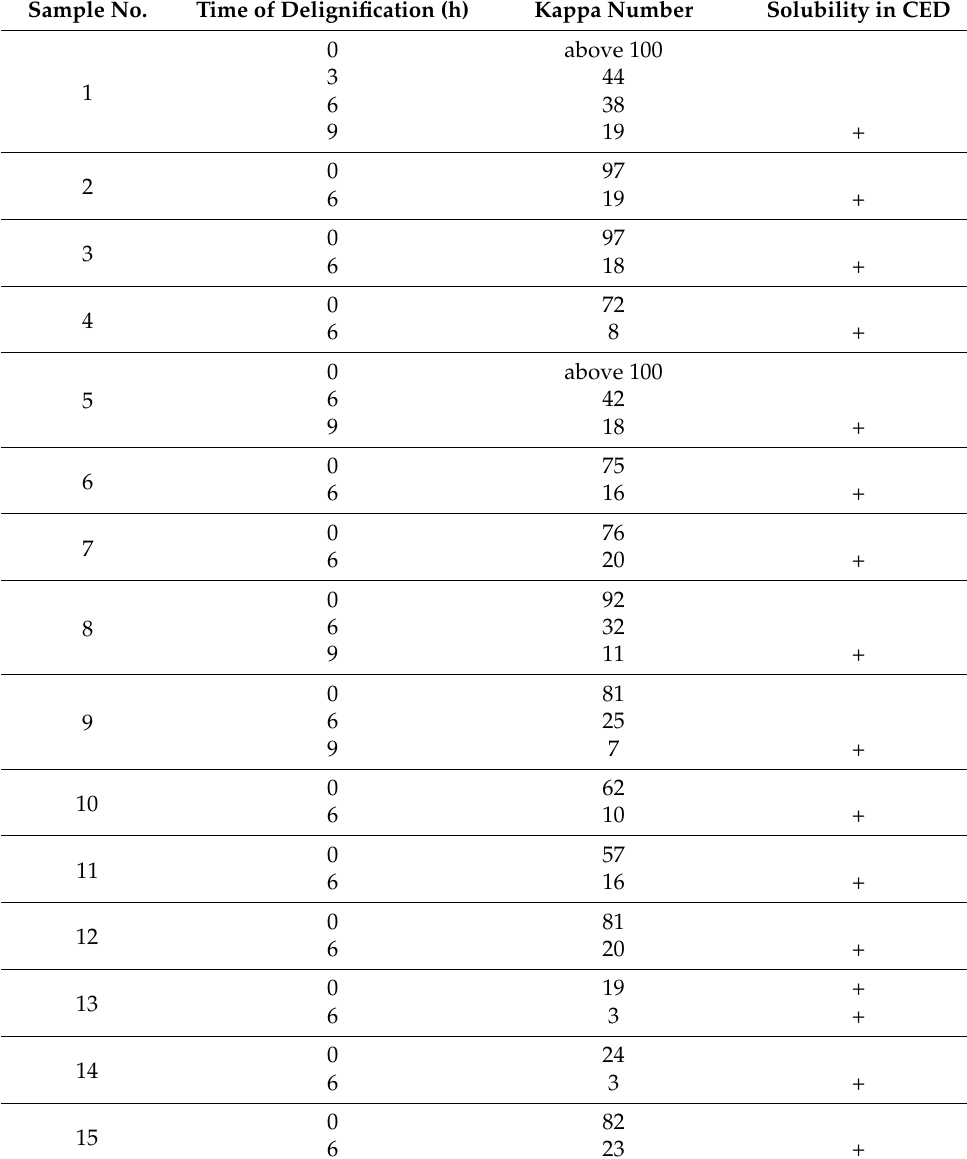
Table 2. Kappa number of paper samples before and after 3, 6, or 9 h of delignification and their solubility in CED (+ indicating completely soluble in CED). The Kappa number is calculated from three measurements with an average RSD of